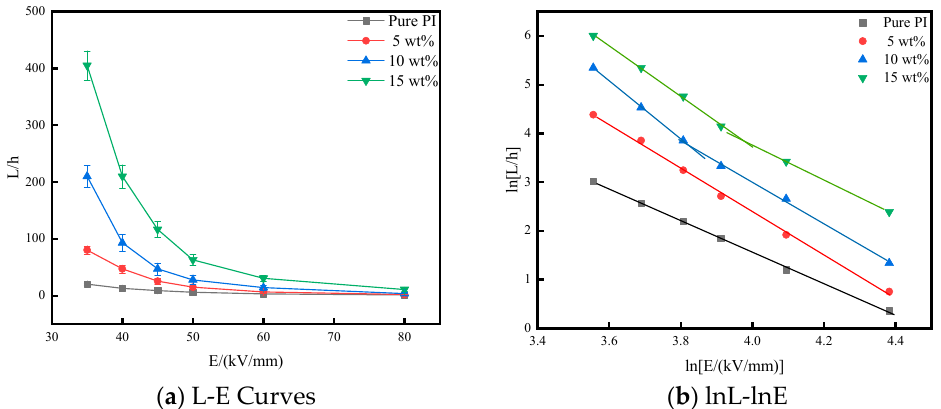
Figure 8. Relationship between field strength and corona-resistant lifespan of pure PI film and PI/SiO 2 composite film at 155 °C, ( a ) is the field strength and corona-resistant lifespan curves, ( b ) is logarithm of electric field strength and corona-resistant lifespan.